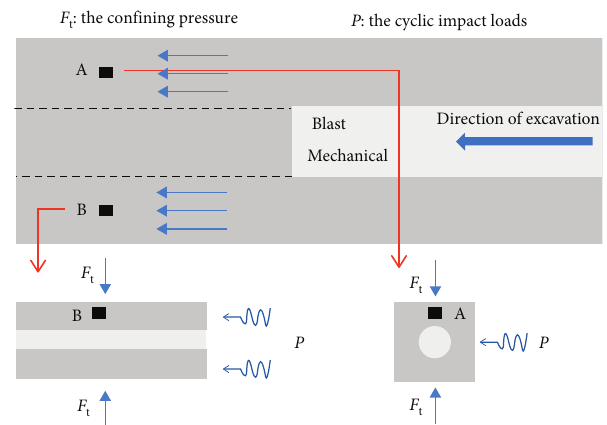
Figure 1: Sketch of rock mass subjected to cyclic dynamic loads in